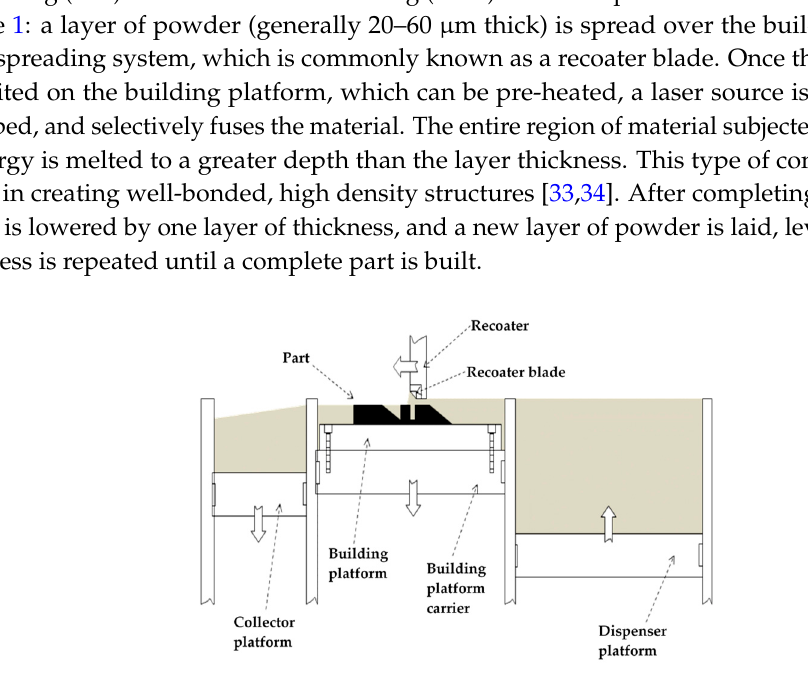
Figure 1. Schematic representation of the Selective Laser Melting (SLM) process.